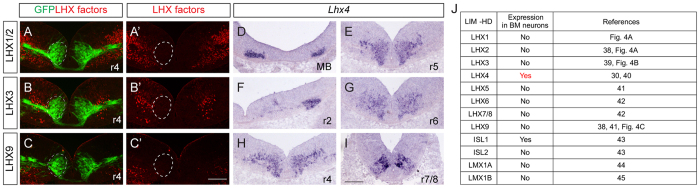
LHX4 is present in BMNs.(A–C’) LHX1/2, LHX3 and LHX9 are not detectable in BM neurons labeled in green in transverse sections of E11.5 hindbrains of ISLMN: GFP-F mice (white dotted lines). (D–I) Lhx4 transcript is present in BM neurons of E11.5 transverse hindbrain sections. (J) A list of LIM-homeodomain transcription factors present in BMNs. Scale bars: in (C’), 100 μm for (A–C’) in (I), 100 μm for (D–I).